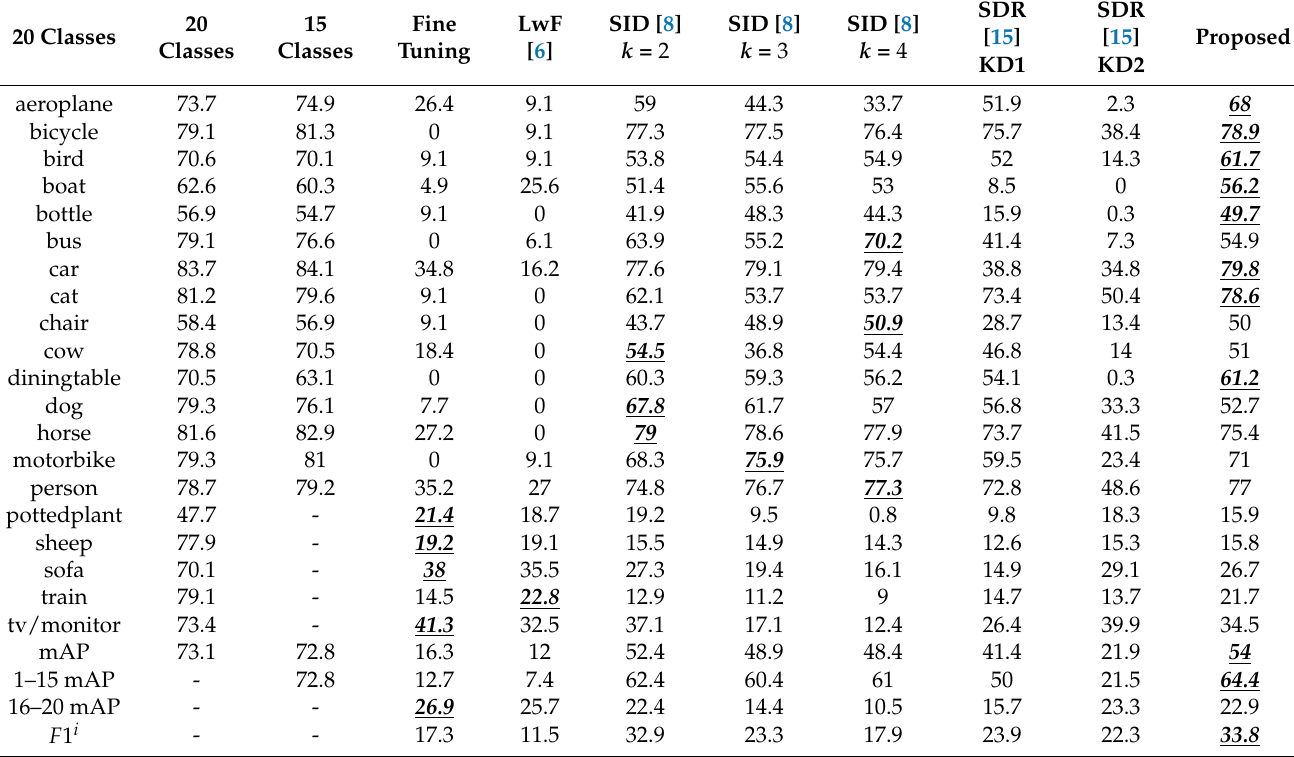
Table 2. Comparison of 15 + 5 Scenario